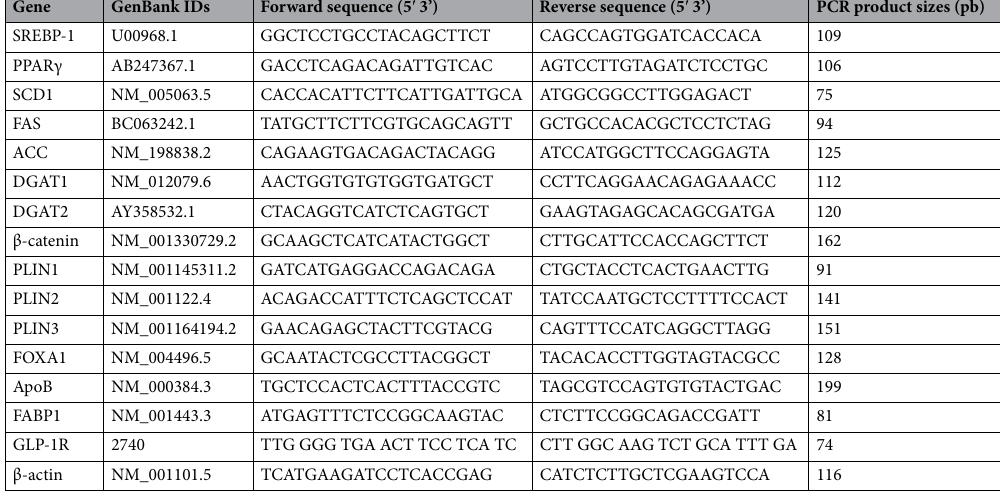
Table 1. Primer list and